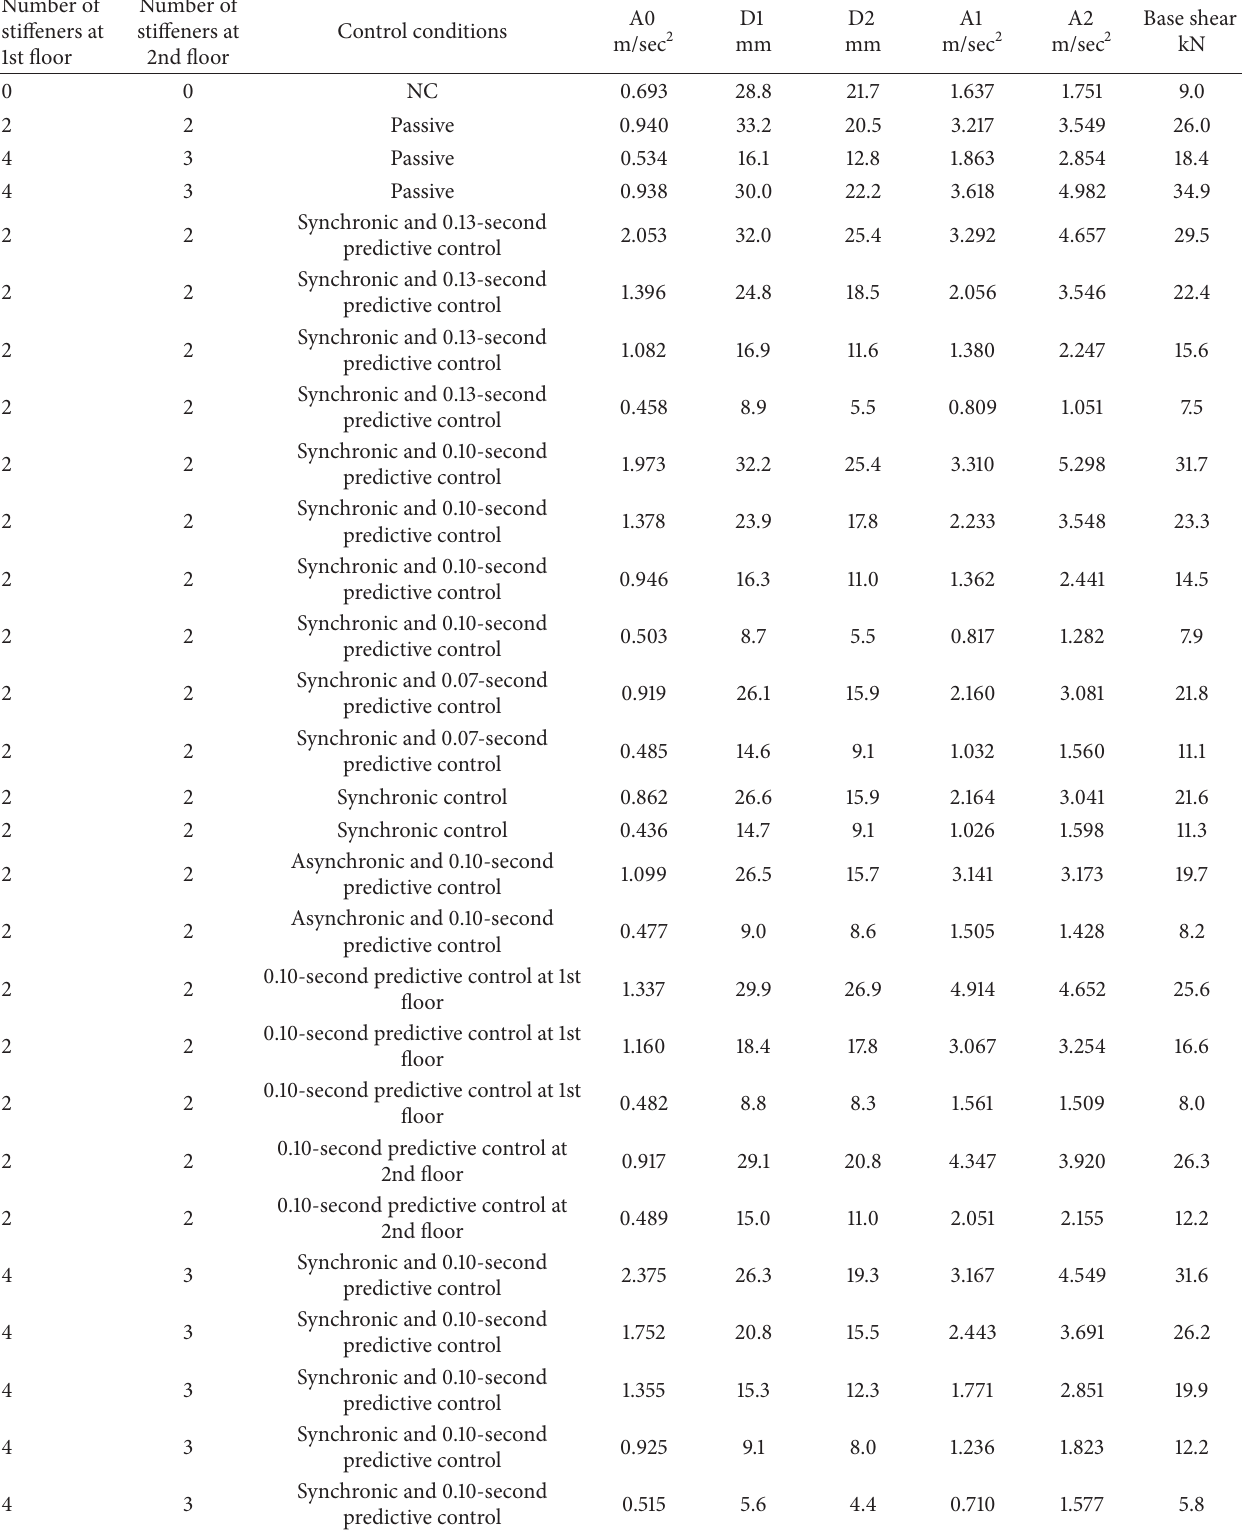
Table 3: The maximum structural response of test structure under excitation of Kobe earthquake record with various control conditions and different peak ground